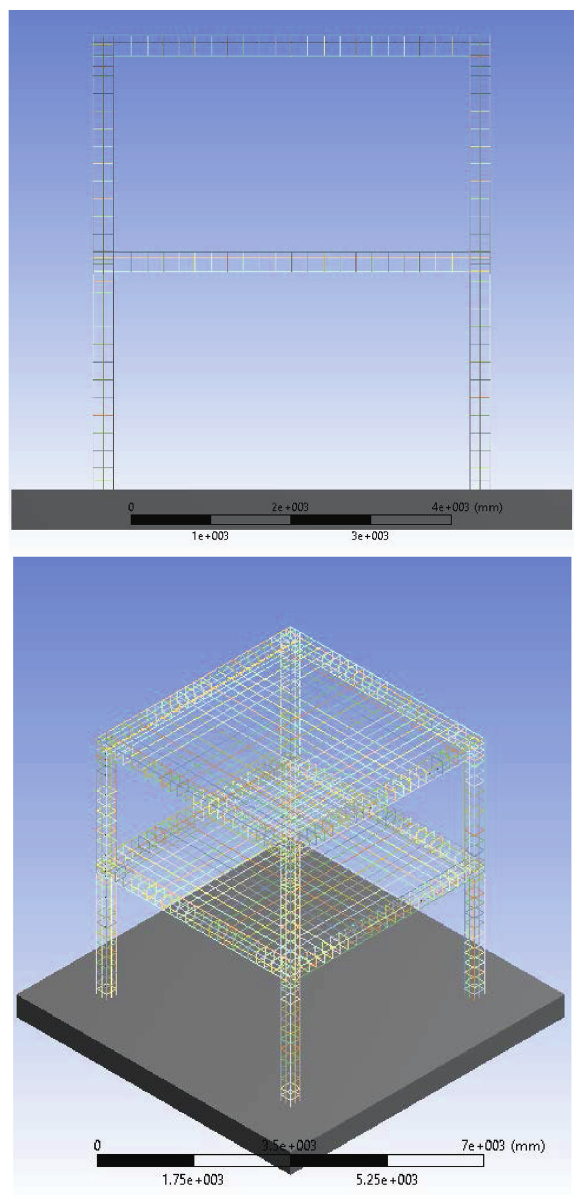
Figure 13: Reinforcement detailing for FRM_REI_DET_#1 on